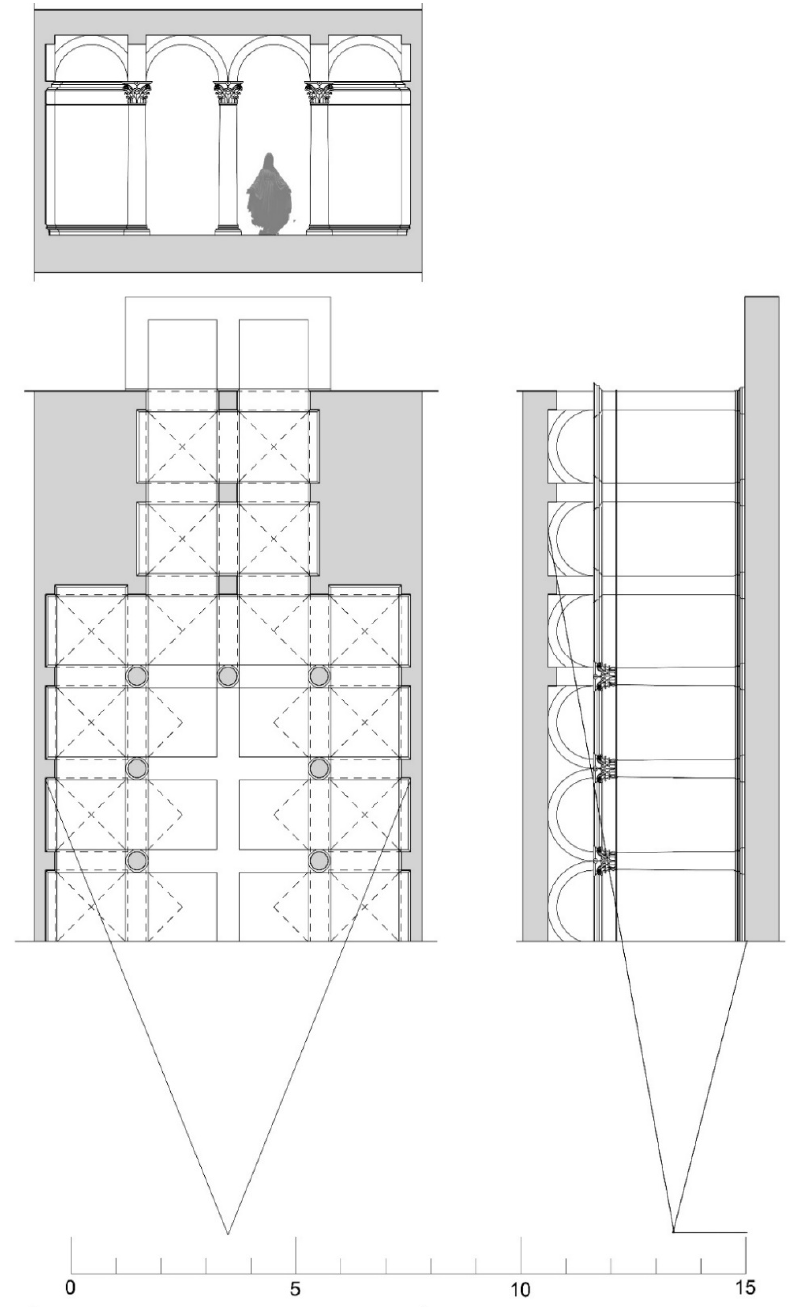
Figure 11. Perspective restitution in the plan, transversal section (above) and longitudinal section (right) with visual cones from Raffaello’s The Annunciation from the Pala degli Oddi , 1503.